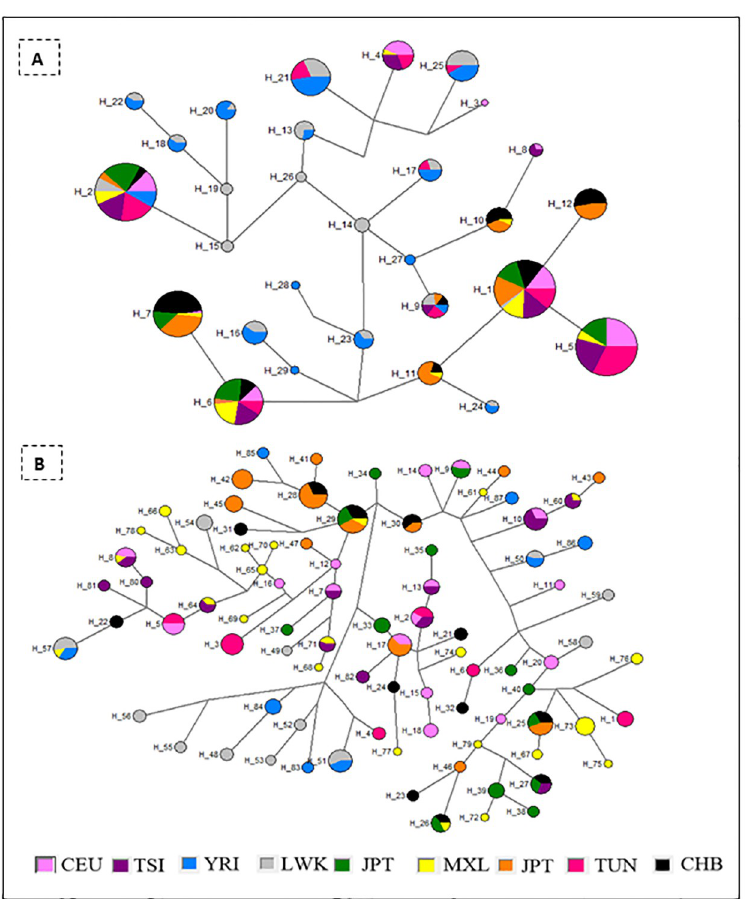
Fig 2. Median-joining haplotype network for BRCA1 (A) and BRCA2 (B) gene. The sizes of the circles are proportional to haplotype frequency and each color refer to a distinct